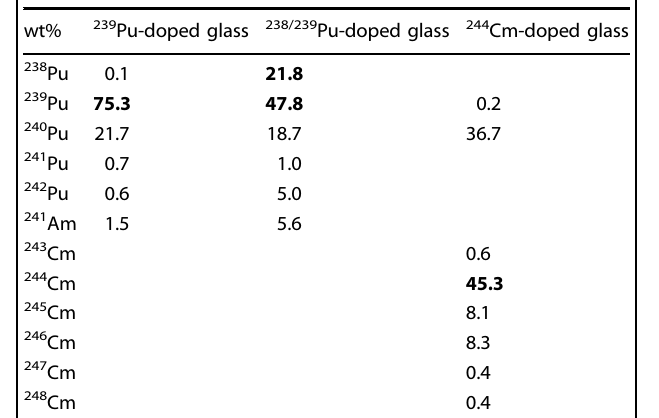
Table 3. Isotopic compositions of the doped glasses at the beginning of the leaching tests (normalized to the Pu and Cm contents).